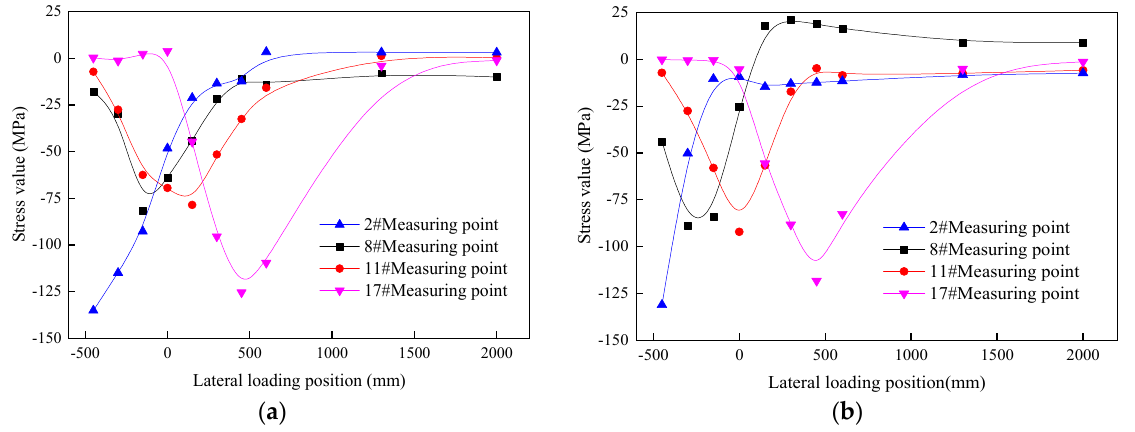
Figure 16. Transverse loading 96# diaphragm (unreinforced) CI area measuring point stress-load position relationship curve: ( a ) The first CI area, ( b ) the second CI area. ② The stress curves before and after reinforcement of 100# cross-sectional plate re- inforced by “arc-cut optimization + steel plate reinforcement” are shown in Figure 17.